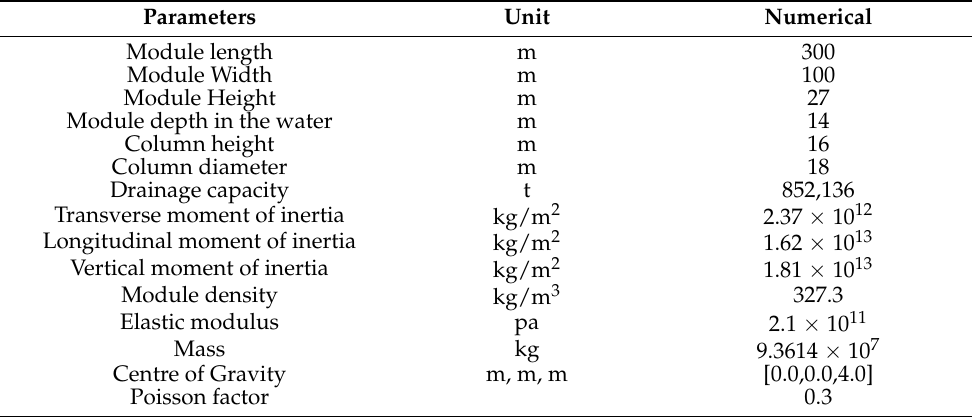
Figure 2. Perspective view of single float module with a numerical water tank. Table 2. Main parameters of single floating body module.